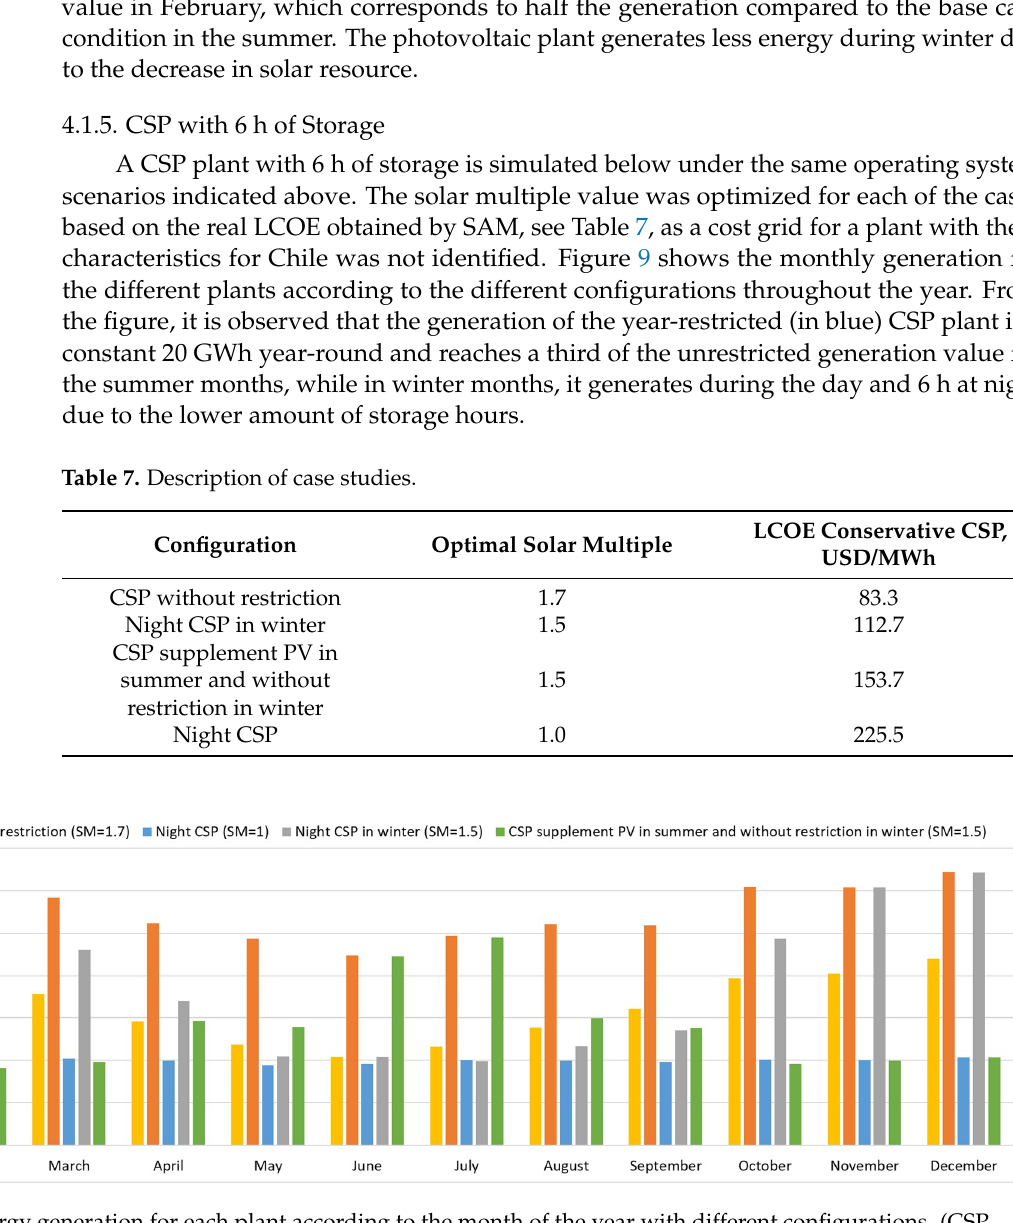
Figure 9. Annual energy generation for each plant according to the month of the year with different configurations. (CSP with 6 h of storage).